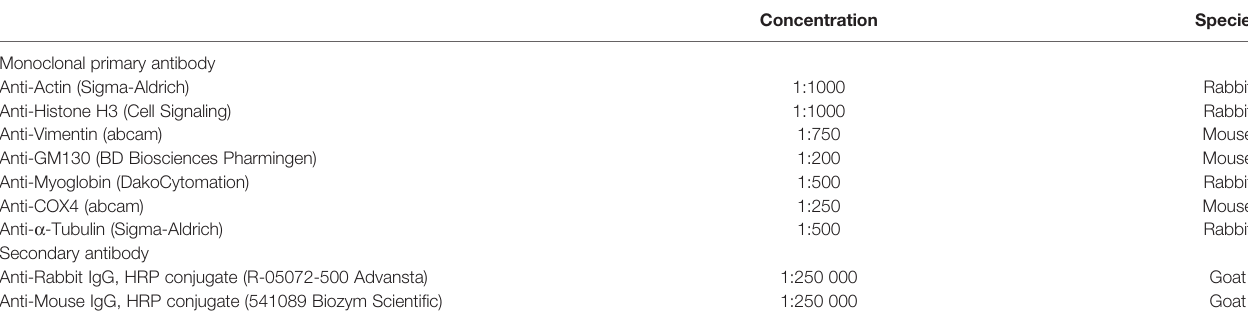
TABLE 3 | Antibodies used for Western blotting of subcellular